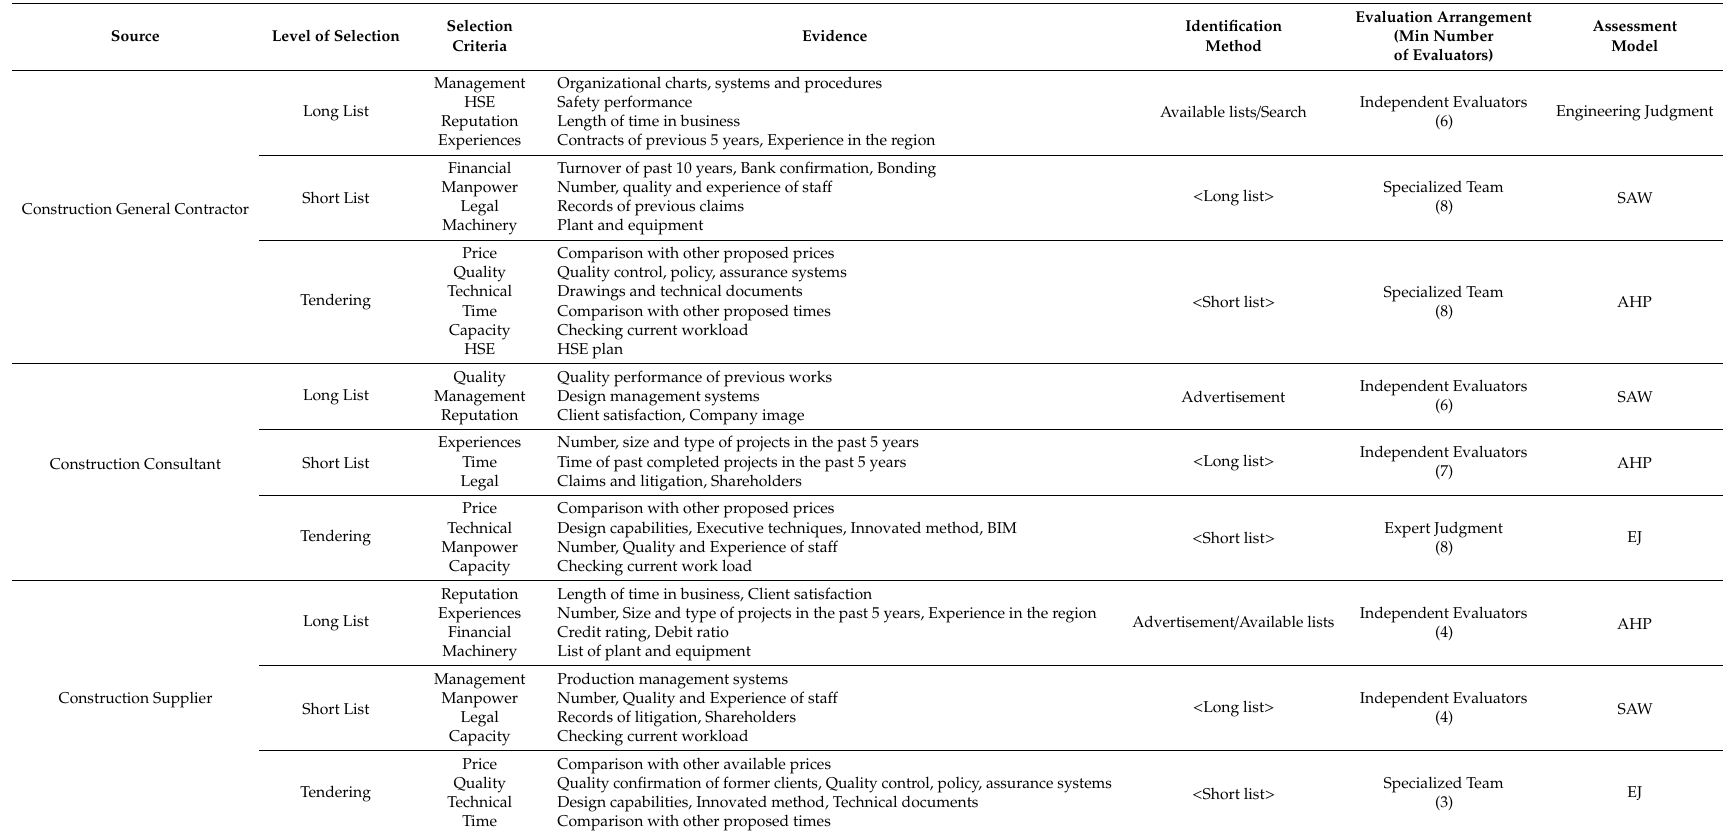
Table 12. Summary of the proposed integrated organizational system for the source